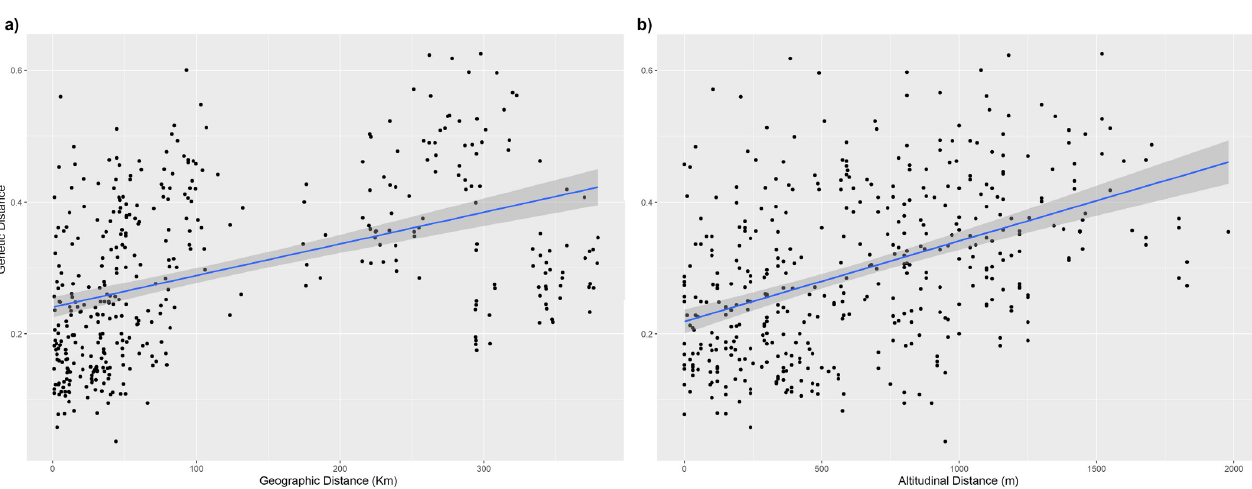
PLOS ONE | https://doi.org/10.1371/journal.pone.0271424 December21,